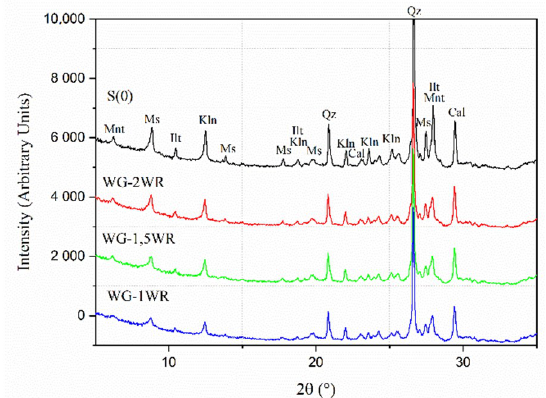
Figure 5. XRD diffraction patterns for different W/P ratio during wet grinding of a Swedish raw clay: S0, WG-1WR, WG-1.5WR, WG-2WR. [Kln-kaolinite, Mnt-Montmorillonite, Ms-muscovite, Ilt-illite, Qz-quartz, Cal-calcite].